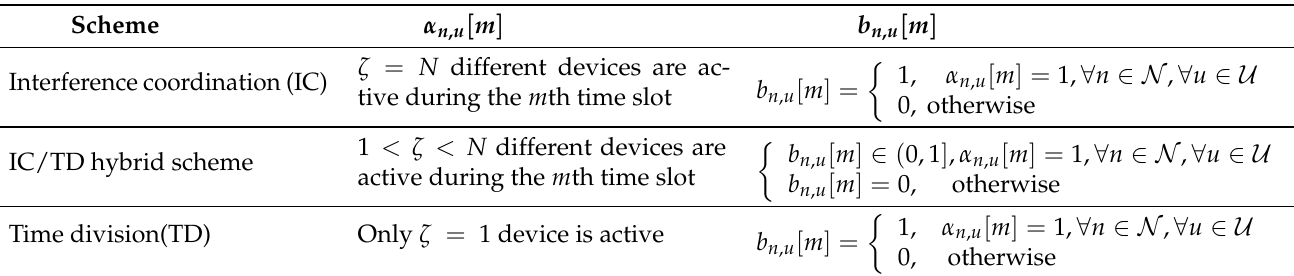
Table 1. Illustration of schemes with different